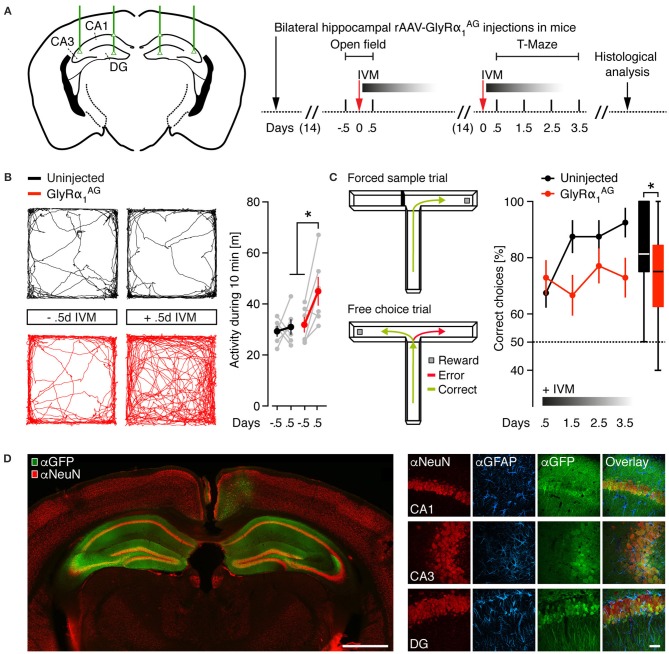
IVM induced hyperactivity and spatial working memory impairment in mice with bilateral neuronal expression of GlyRα1AG in the dorsal hippocampus. (A) Left: Injection scheme, green lines and triangles indicate the coordinates used for bilateral stereotactic rAAV-syn-GlyRα1AG-2A-Venus injections into the dorsal hippocampus of mice (DG, dentate gyrus; CA1 and CA3, cornu ammonis 1 and 3). Right: Time line of the experiment. (B) Left: Representative trace diagrams in an open field of one virus uninjected control and one GlyRα1AG transduced mouse before (−0.5 d) and after (+0.5 d) IVM exposure. Right: GlyRα1AG transduced mice showed a hyperactive phenotype 0.5 days after the i.p. injection of IVM; GlyRα1AG
n = 6, Uninjected n = 6; data shown as means ± SEM; *p < 0.05. (C) Left: The two phases of the T-Maze rewarded alternation task: One arm is randomly blocked in the first trial (Forced sample trial) and re-opened in the second trial (Free choice trial); alternations in the free choice trial are counted as correct, while re-entries into the same arm as entered in the forced sample trial are counted as error. Right: 0.5–3.5 days after IVM injection, GlyRα1AG expressing mice performed worse than virus uninjected control mice in the rewarded alternation task; GlyRα1AG
n = 6, Uninjected n = 5; data shown as means ± SEM; box plot on the right shows cumulative data over all days and trials (median, 25th/75th percentile, *p < 0.05). (D) Left: Representative image of a coronal brain section from one rAAV-syn-GlyRα1AG-2A-Venus injected mouse [αNeuN (red) and αGFP (green) staining]; Venus expression is prominent in both hippocampi; scale bar: 1 mm. Right: Confocal imaging (maximum intensity projections) of hippocampal subregions in coronal brain slices from a rAAV-syn-GlyRα1AG-2A-Venus injected mouse, immunostained for αNeuN (red), αGFAP (blue), and αGFP (green); note colocalization of NeuN and GFP fluorescences; scale bar: 20 μm.